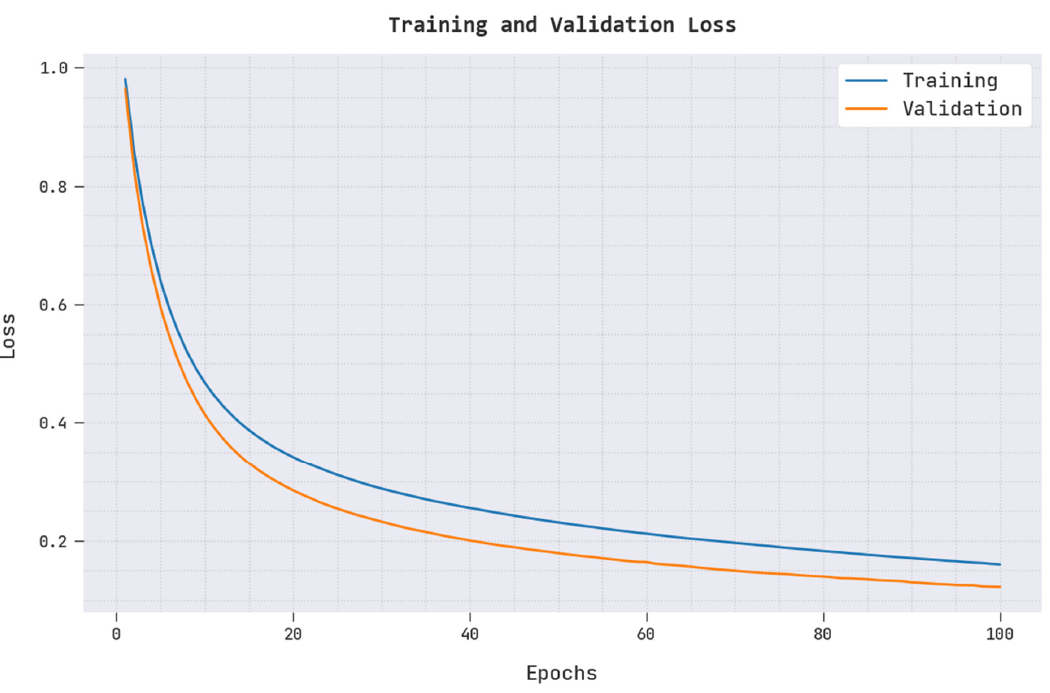
Figure 5. TRAL and VALL of ARAC ‐ AOADL model.